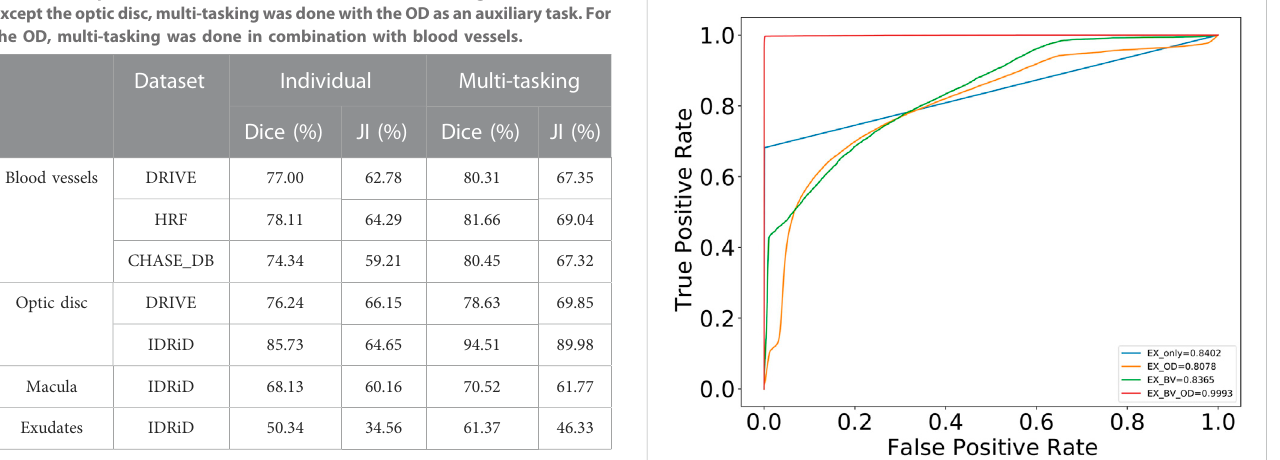
FIGURE 4 ROC-AUC curves for different experiments on exudate